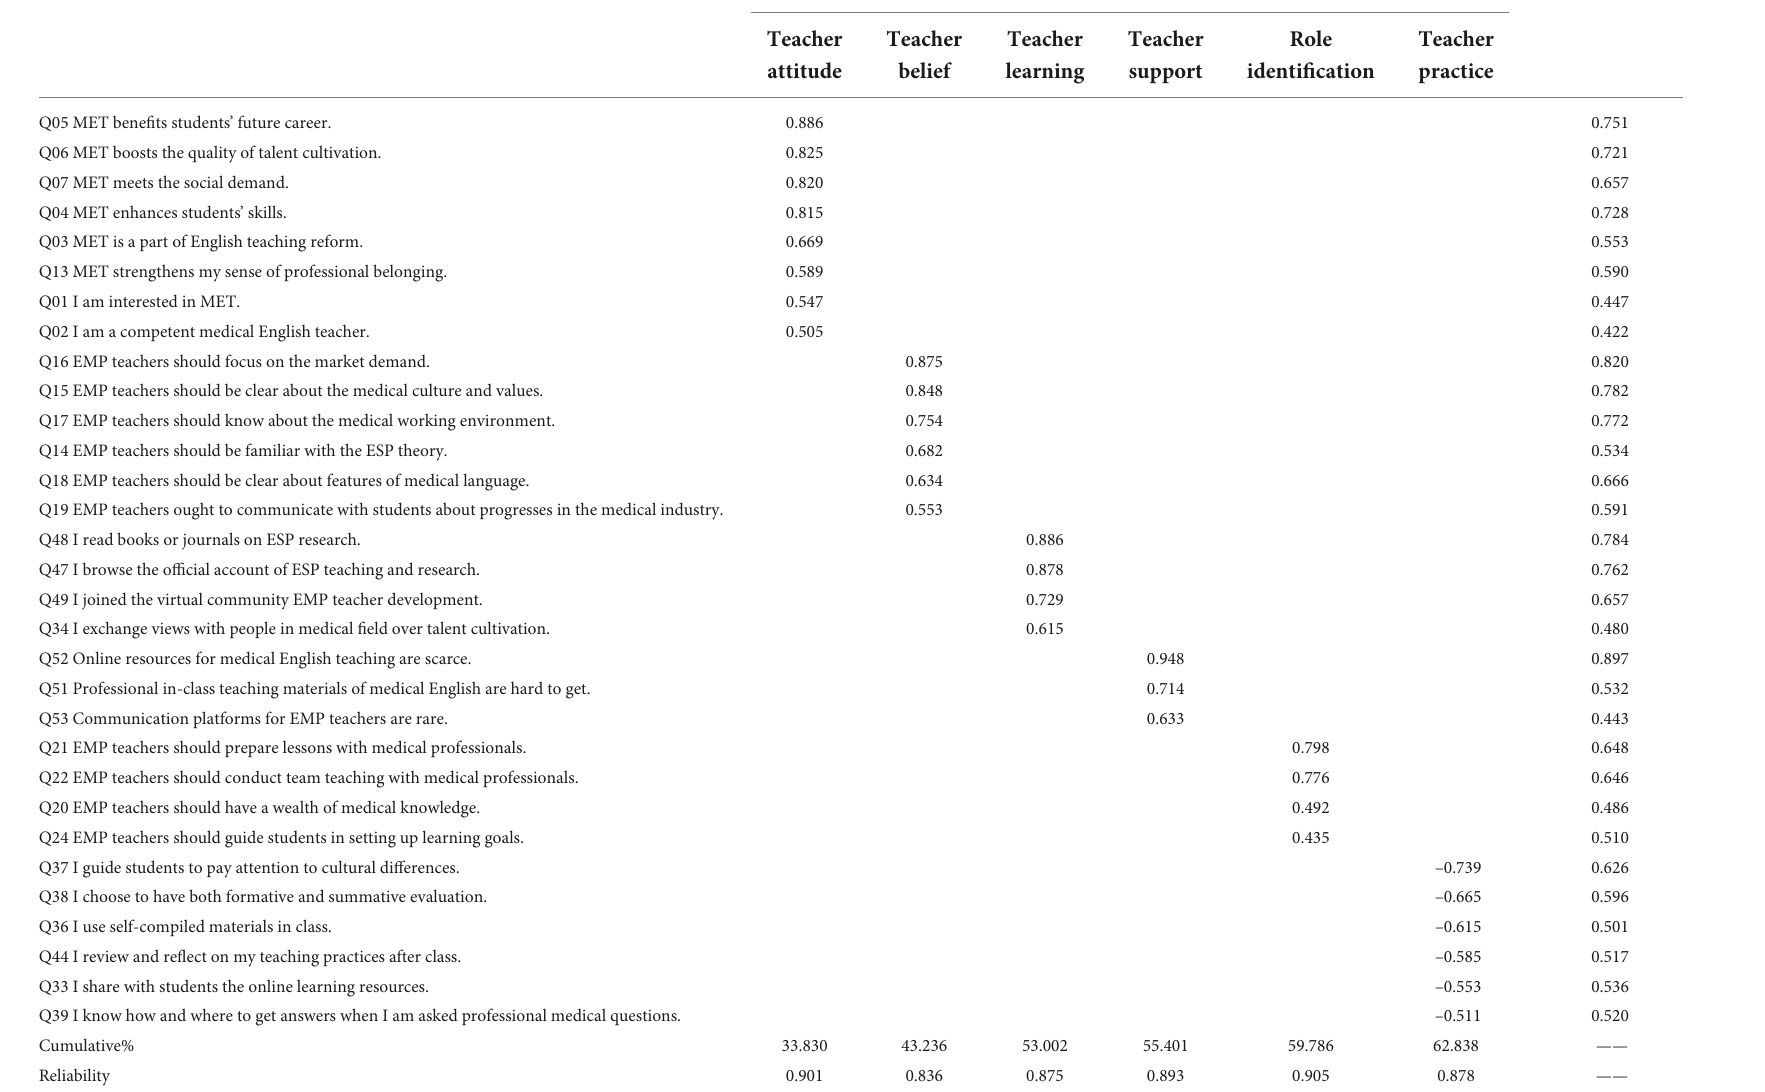
TABLE 1 Exploratory factor analysis (EFA) results of the 31-item scale (pattern matrix). Items Factor